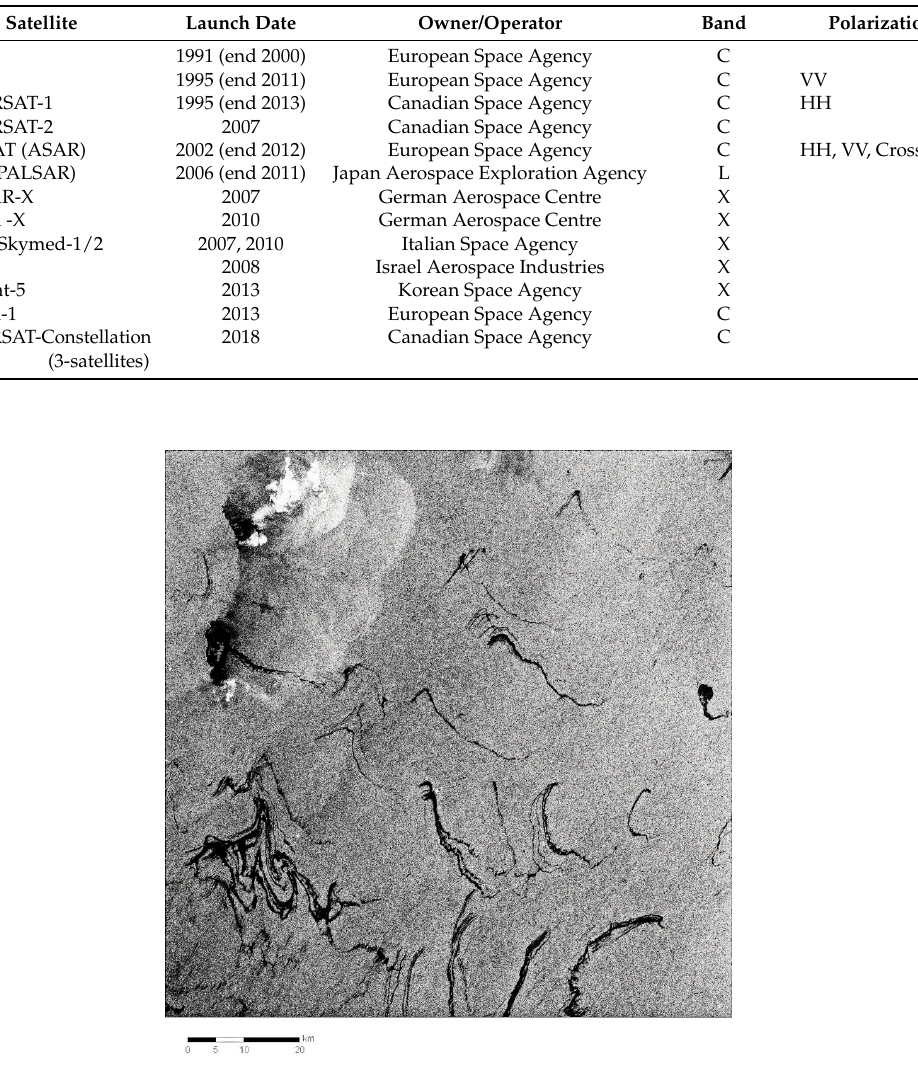
Figure 8. RADARSAT-2 view of leaking oil platforms in the Caspian Sea (Image from Macdonald-Detwiler).